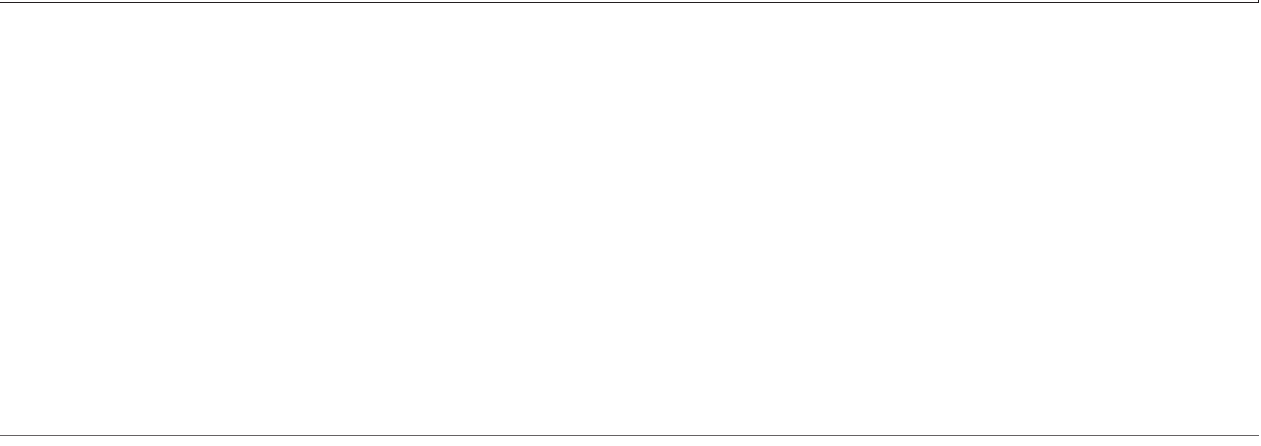
FIGURE A1 | Ratio OPAQSW/OPAQ m as a function of OPAQ m for warm season (left) and cold season (right). Open circles are weighted mean of all the